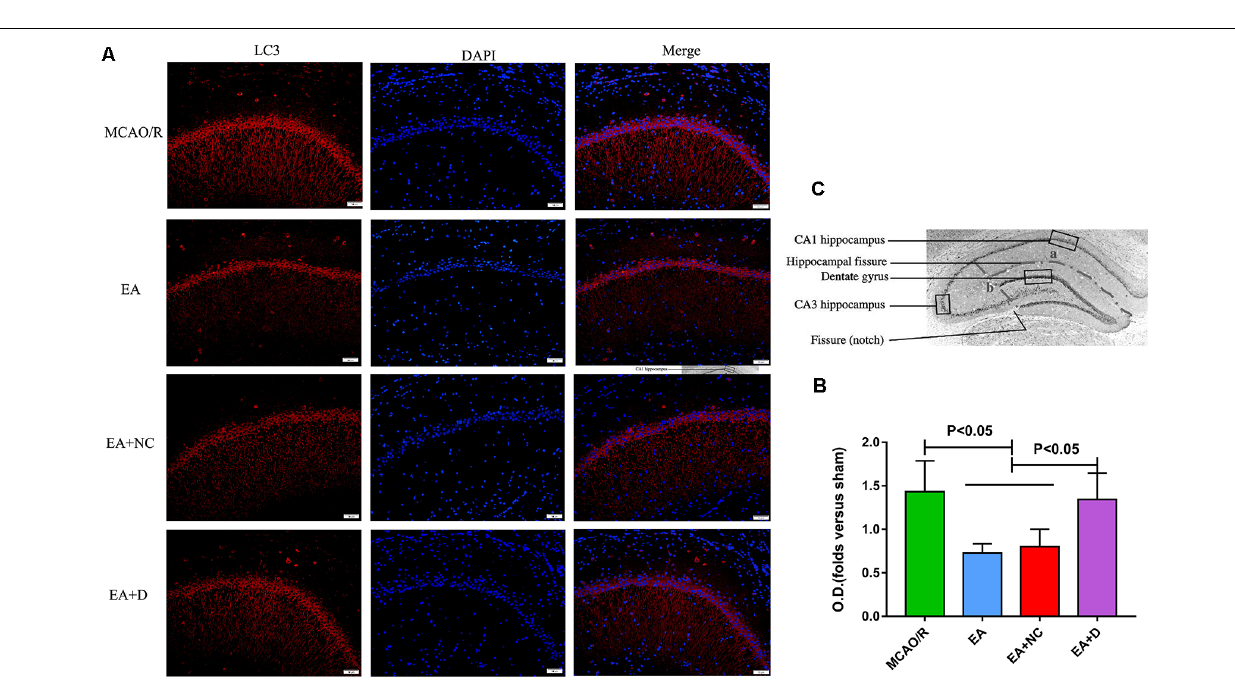
Frontiers in Cellular Neuroscience | www.frontiersin.org